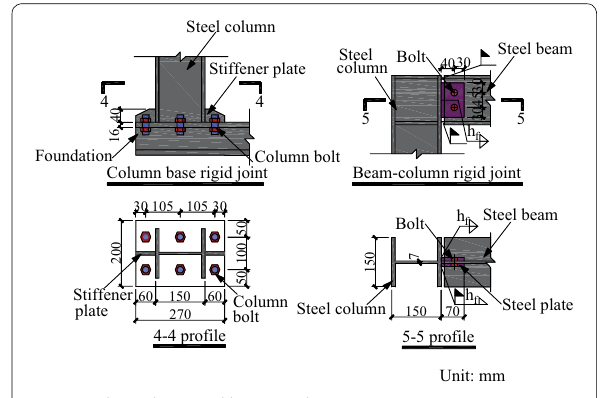
Fig. 4 Column base and beam–column connection